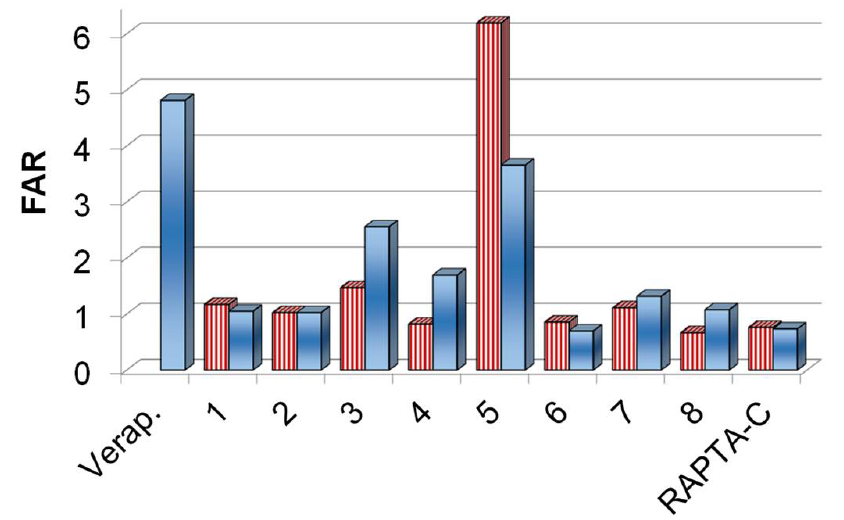
Figure 1. ABCB1 modulating activity on multidrug-resistant Colo 320 colonic adenocarcinoma cells in the presence of complexes 1 – 8 , RAPTA-C at 2 μM (stripped bars) and 20 μM (full bars) concentrations. Verapamil (Verap.) was used as a positive control at 20 μM.